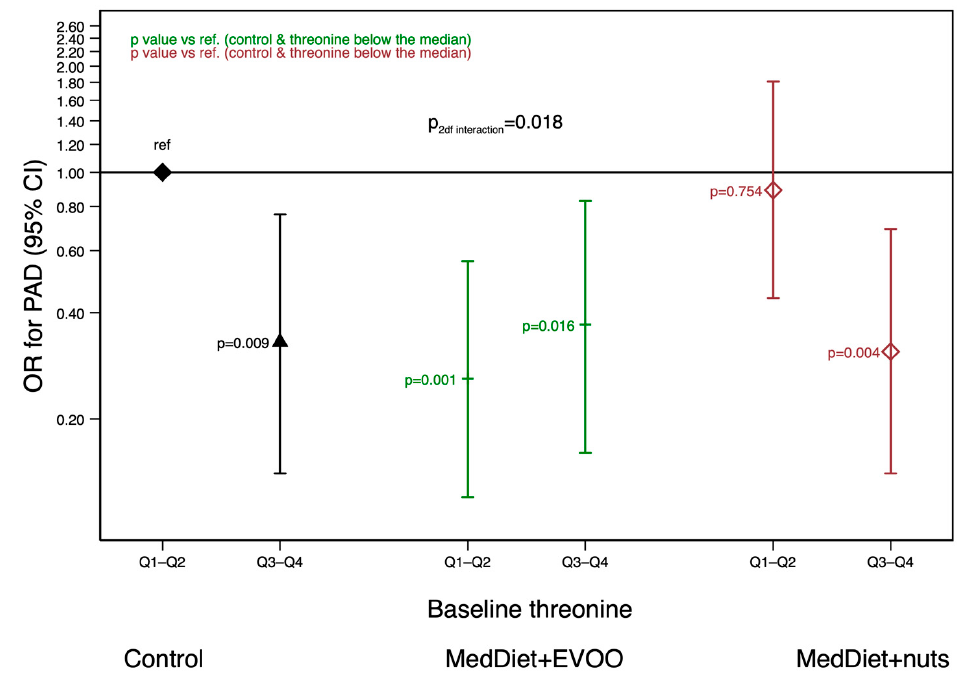
Figure 1. Matched odds ratios (95% CI) for the association between baseline threonine (below/above the median) and incident peripheral artery disease (PAD) within each PREDIMED intervention arm. Multivariable model adjusted for the intervention group (Mediterranean diet vs. control group), body mass index (kg/m 2 ), smoking (never, current, former), leisure-time physical activity (metabolic equivalent tasks in min/d), prevalent chronic conditions at baseline (dyslipidemia, hypertension and diabetes), educational level (primary or lower/secondary or higher) and propensity scores predicting randomization to account for small between-group imbalances at baseline. MedDiet: Mediterranean